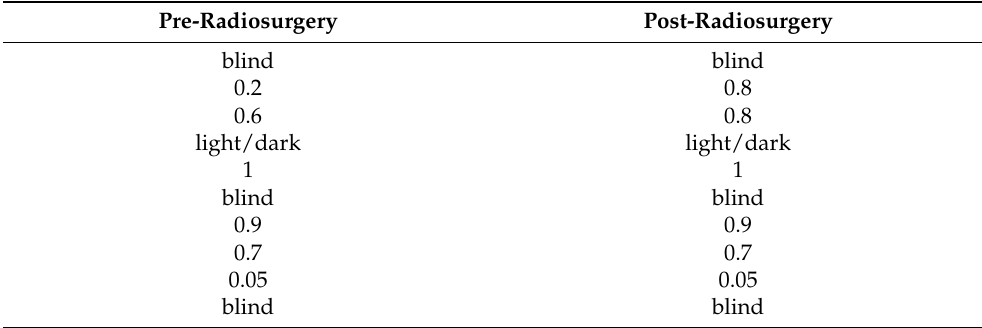
Table 1. Visual acuity 1 per patient pre- and